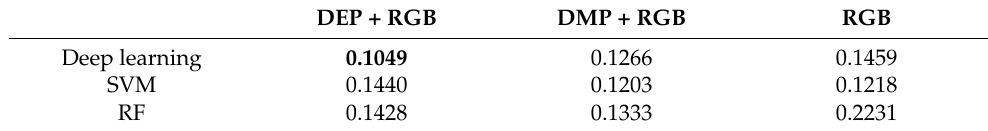
Table 9. Total disagreement for World-View 2 dataset.